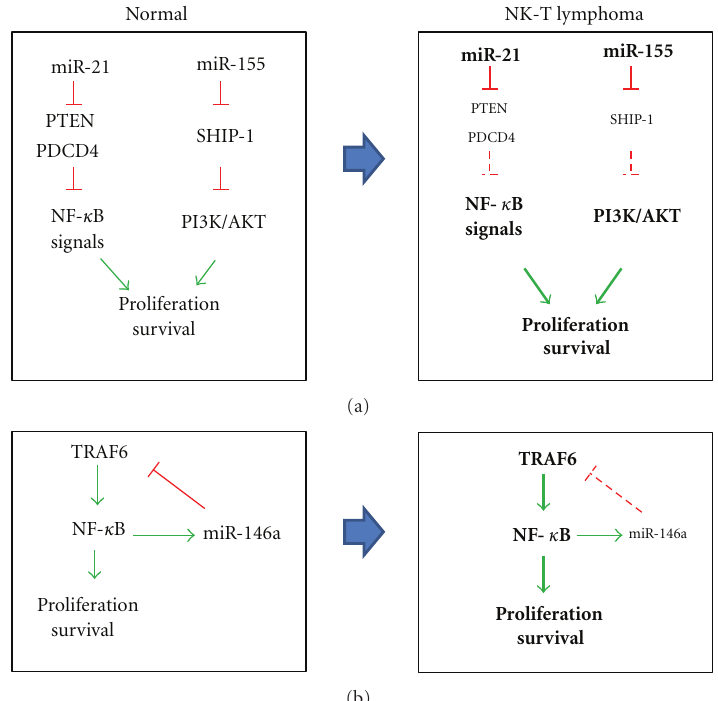
Figure 3: Summary of miRNA alterations identified in NK/T malignancies and proposed mechanisms of altering cell growth and survival. (a) Increased miR-21 and miR-155 was identified in malignant cases by Yamanaka et al. [31]. (b) Decreased miR-146a were identified in malignant cases by Paik et